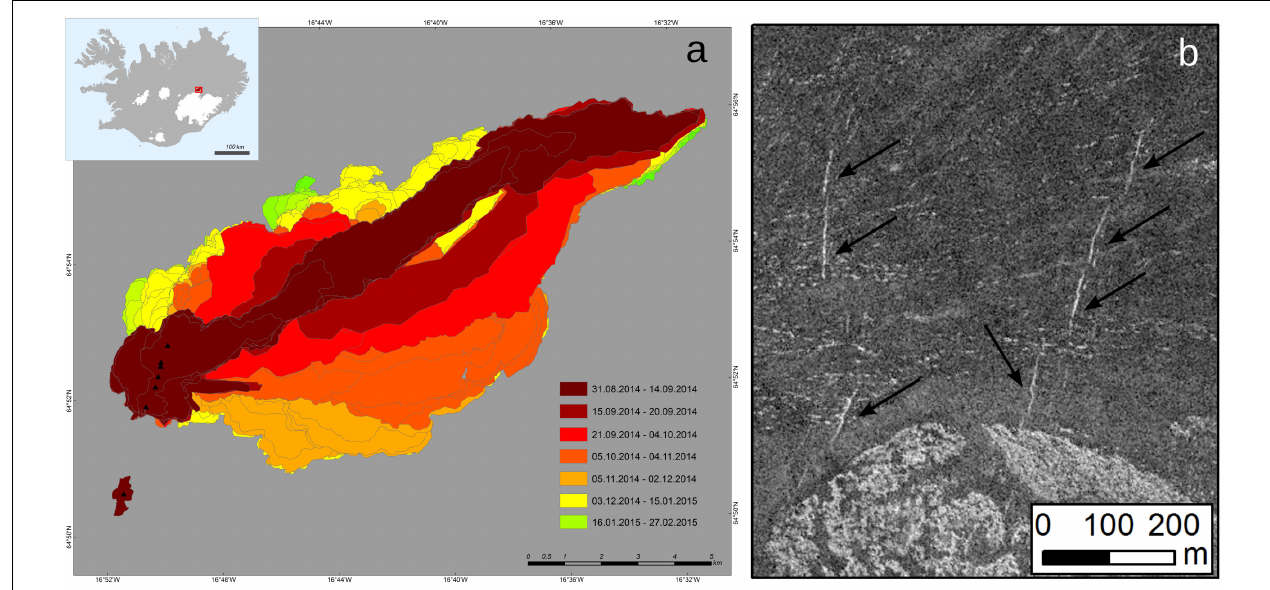
FIGURE 6 | Detecting surface changes using amplitude SAR images. (a) Time evolution of the lava field area deduced from the mapping of the lava outlines using a combination of various remote-sensing data including SAR aerial and satellite data. (b) SAR aerial image covering northern part of Vatnajökull glacier and the South of Holuhraun eruption site and showing fissures (arrows) that formed with the dyke emplacement late August 2014. Modified from Hjartardóttir et al. (2016) with permission of